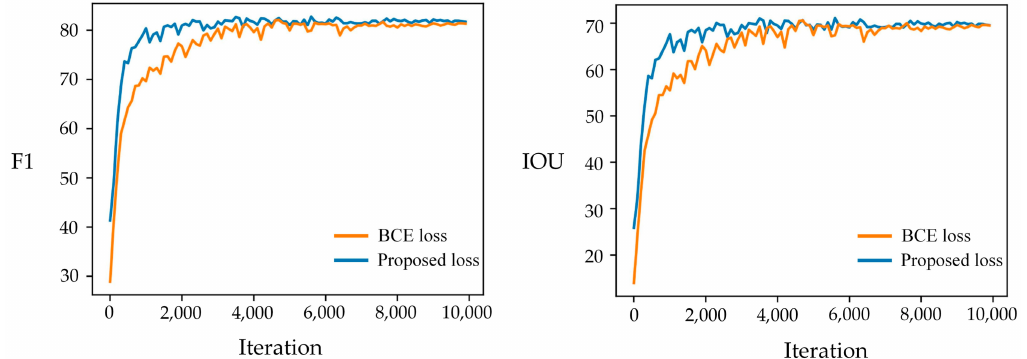
Figure 8. Curve of IOU and F1 score under different loss.